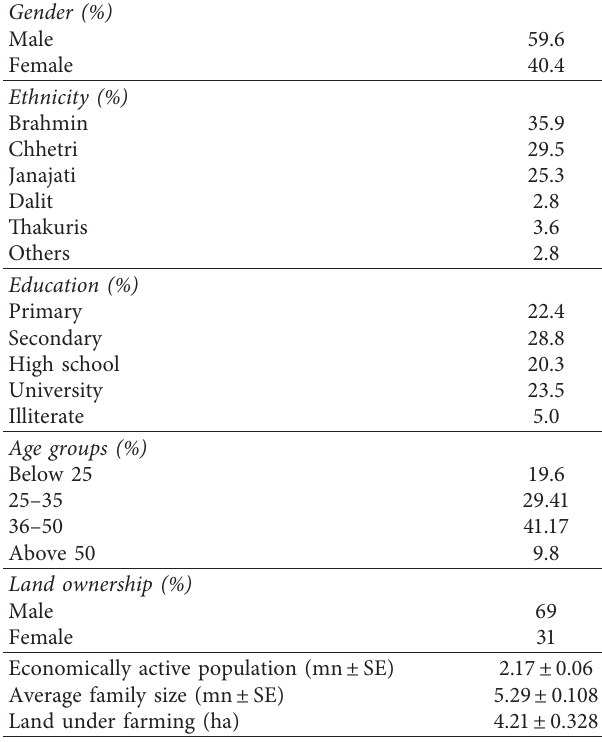
Table 3: Socioeconomic characteristics of the study